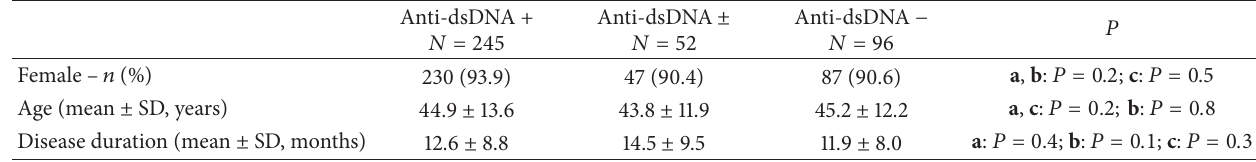
Table 1: Demographic characteristics of the SLE patients ( 𝑁 = 393 ) according to the anti-dsDNA status . Anti-dsDNA + 𝑁 = 245